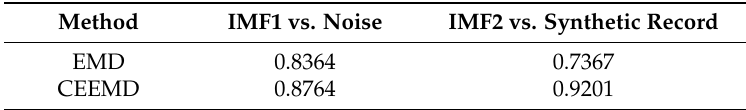
Table 1. Correlation coefficients of IMF vs. Noise and Synthetic Record.